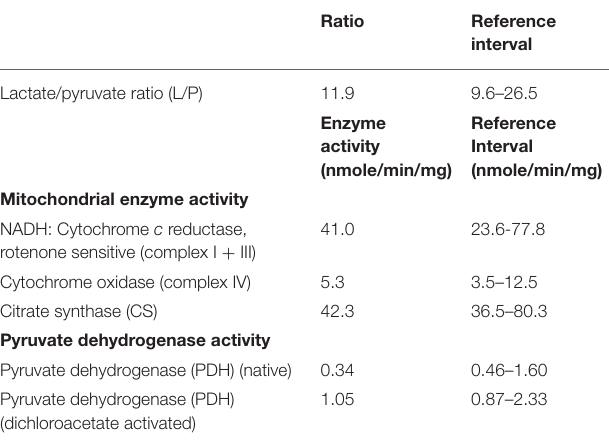
TABLE 3 | Analysis of confluent skin fibroblast cultures.